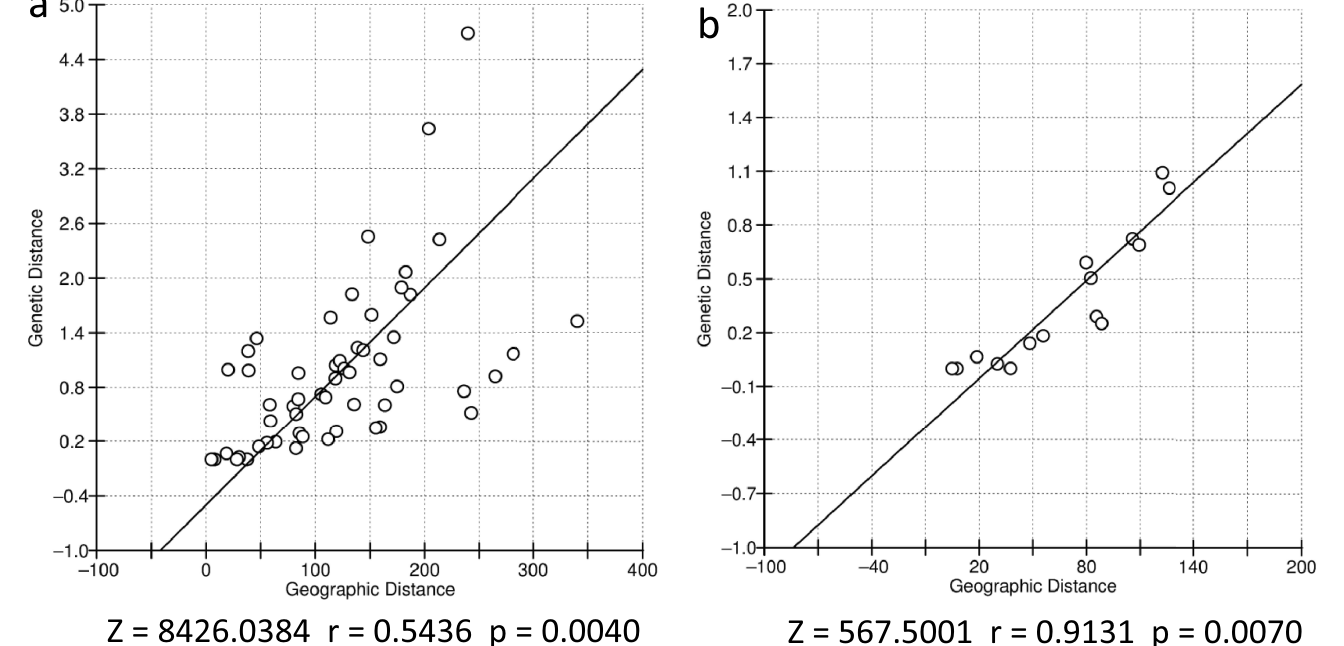
Fig 4. Mantel test results. Correlation coefficient values and p-values for the null hypothesis of r � 0 are indicated below the graphics. A) Complete southern clade. B) Continuous core region in southern Espinhac¸o.